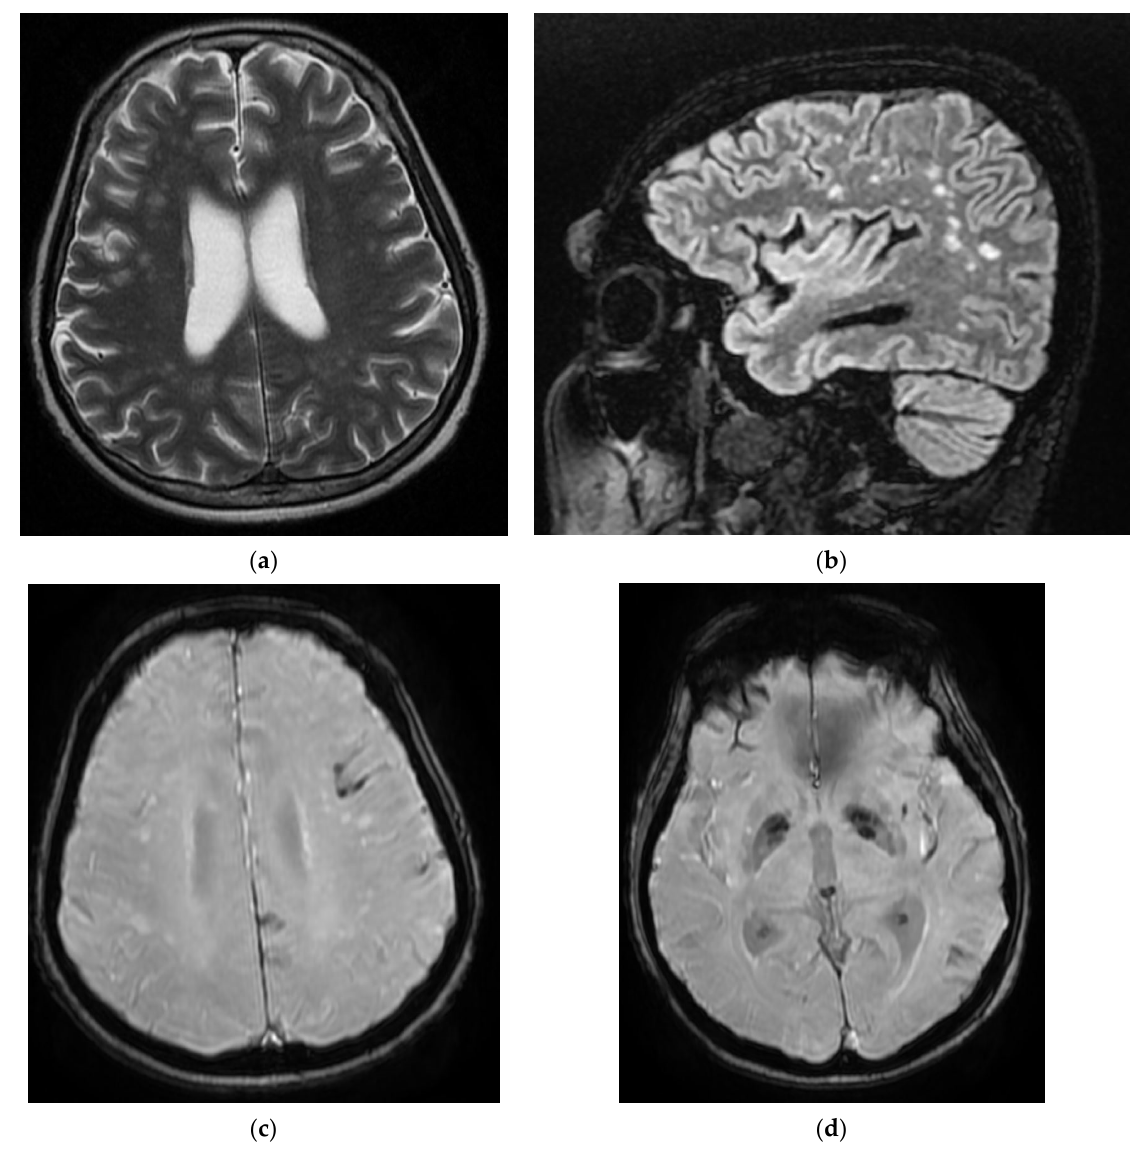
Figure 3. MRI images of the Case 3 patient reveal multiple centimetric lesions in T2/FLAIR hyper- signal ( a , b ), with no diffusion restriction, disposed in a white hemispheric substance in the bilateral subcortical frontal–temporal–parietal area, as well as in the right cerebellar hemisphere, and su- pratentorial demyelinating lesions most probably with an ischemic vascular sublayer. Additionally, linear and curvilinear traces in SWAN signal ( c , d ), disposed in the left cortical parietal, frontal area–frontal cortical and left parietal hemosiderosis.